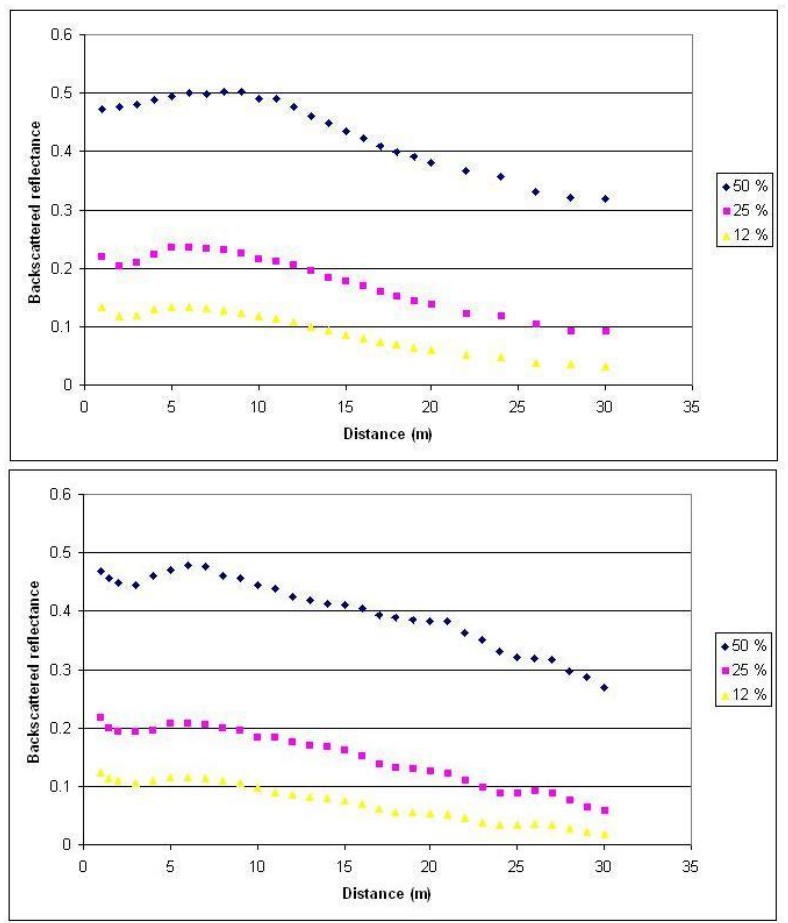
Figure 6. FARO: 2007 stationary (top) and 2009 profiler mode (bottom) distance measurement with logarithmic correction, and calibrated with 99% Spectralon at the same distance as the target.